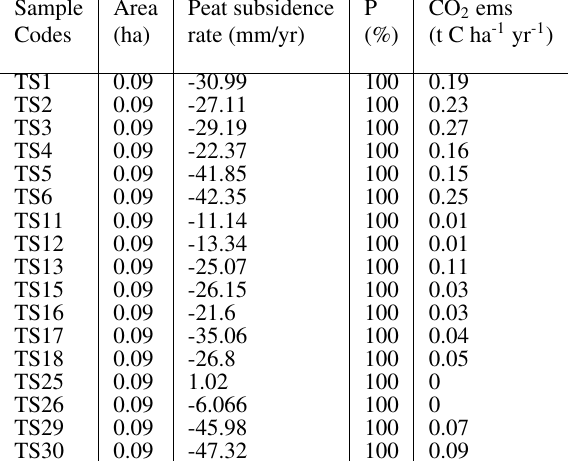
Figure 6. The field documentation was located at the point of TS5 and TS6. The in situ data was collected along a stream Table 2. Estimation of CO 2 emissions (ems) based on point-wise where part of the small peat deposits was visible and the access in-situ data in Banjar Regency and Banjarbaru City, South was relatively easy.